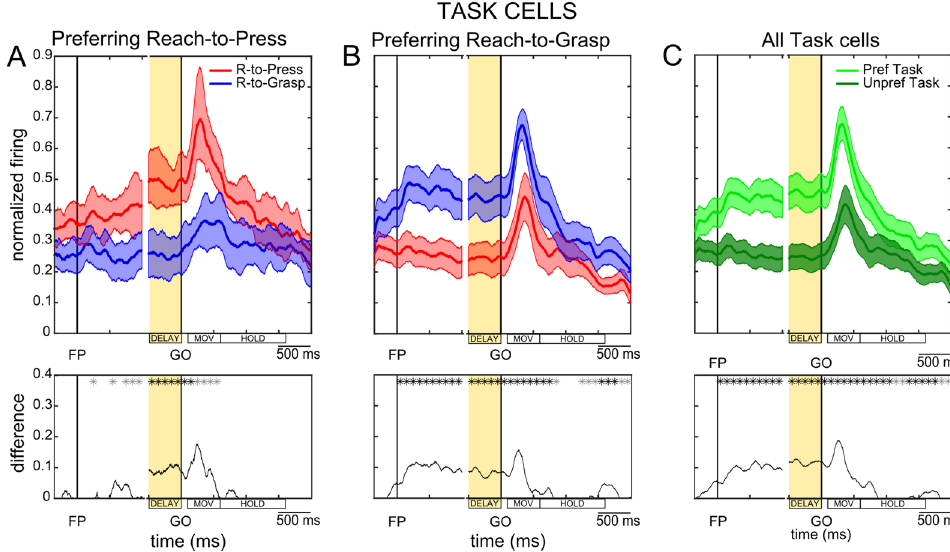
Figure 4. Task-related modulations during the DELAY epoch. ( A ) Average population activity for Task cells showing a preference for reach-to-press movements. In the upper panel, population SDFs are shown separately for the Reach-to-Grasp (in blue) and the Reach-to-Press (in red) tasks, averaged across background conditions. Alignment of neural data was identical to what described for Fig. 3. Shaded red and blue areas indicate 95% confidence intervals (CI) computed using a subsampling procedure (see Methods). In the lower panel, the thin black line represents positive values ( > 0) of the difference between the lower CI limit of the curve identifying the preferred task and the upper CI limit of the curve identifying the non-preferred task. Asterisks reported on the same graph represent instead the results of two-tailed paired Wilcoxon tests comparing experimental conditions, performed on the activity measured in consecutive 100 ms time windows along the whole duration of the trial, beginning after the presentation of the fixation LED (epoch FIX); * in gray = p < 0.05; * in black = p < 0.01. ( B ) Average population activity for Task cells showing a preference for reach-to-grasp movements. All conventions as in panel A. ( C ) Population SDFs represent the temporal unfolding of task preference across the whole population of Task cells , as assessed by averaging spiking activity during the preferred (green) vs. unpreferred task (dark green), again across background conditions. All conventions as in panel